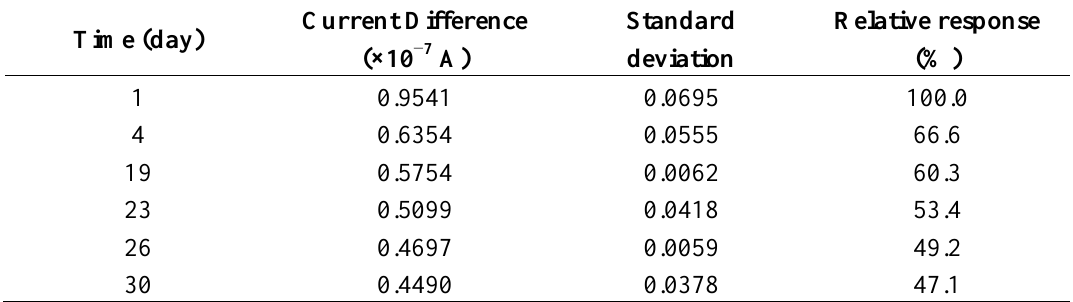
Table 1. The stability of the reagentless NH 4+ ion biosensor tested in solution